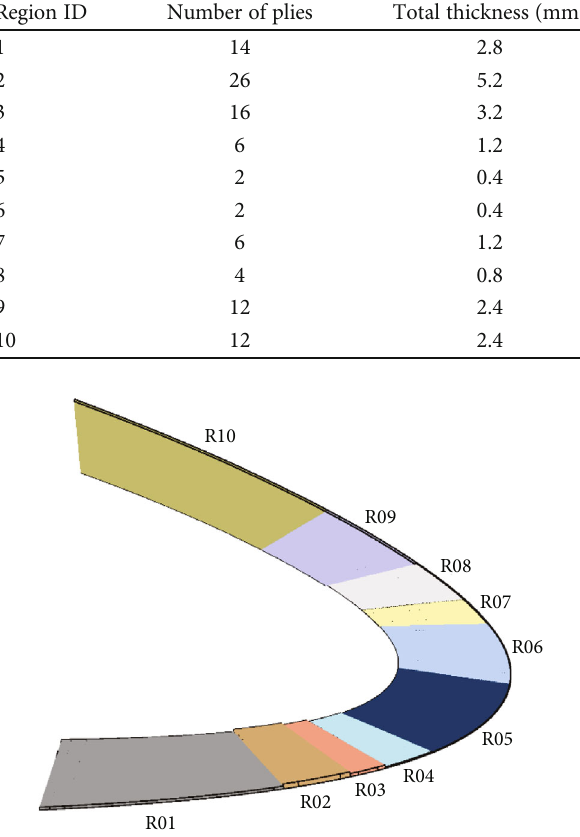
Figure 5: Skin partition and region identi fi ers.